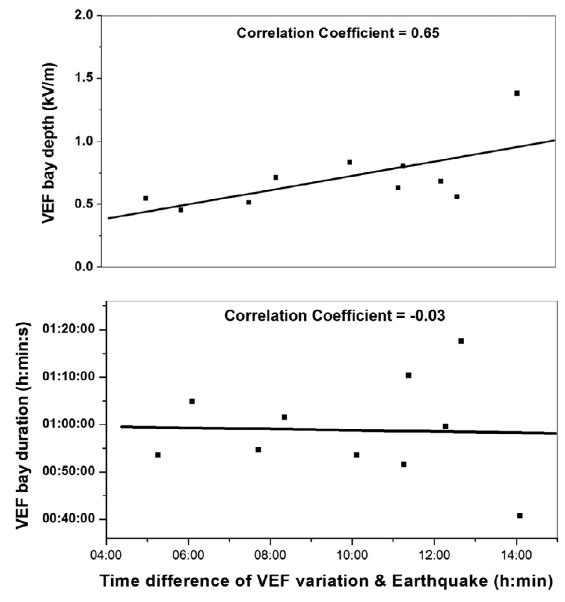
Figure 6. Correlation plot between the distance of the earthquake epicenter to the receiver and the VEF bay depth (top) and VEF bay duration (bottom).